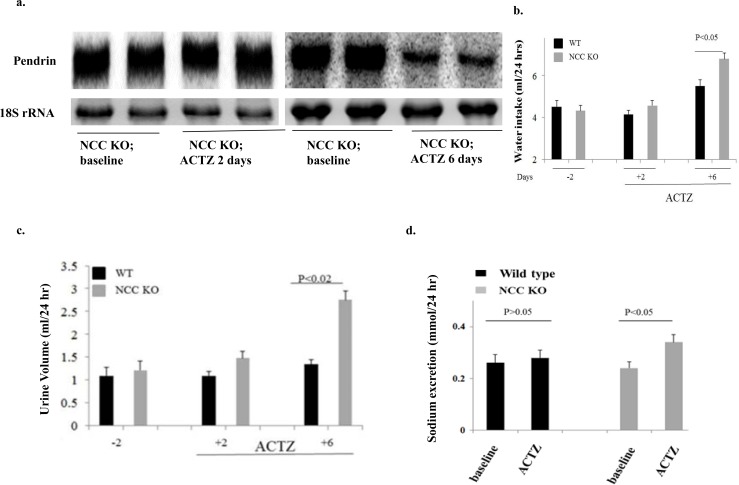
Effect of Acetazolamide on pendrin expression, urine output and water intake in WT and NCC KO mice.Fig 5a shows the expression of pendrin in WT and NCC KO mice treated with acetazolamide for 2 or 6 days (left and right panels). Fig 5b and 5c depicts the urine output (i) and water intake (ii) in WT and NCC KO mice treated with ACTZ. The increase in urine output by ACTZ in NCC KO mice correlated with a reduction in pendrin expression. Fig 5d demonstrates enhanced sodium excretion by ACTZ in NCC KO mice vs. WT animals.